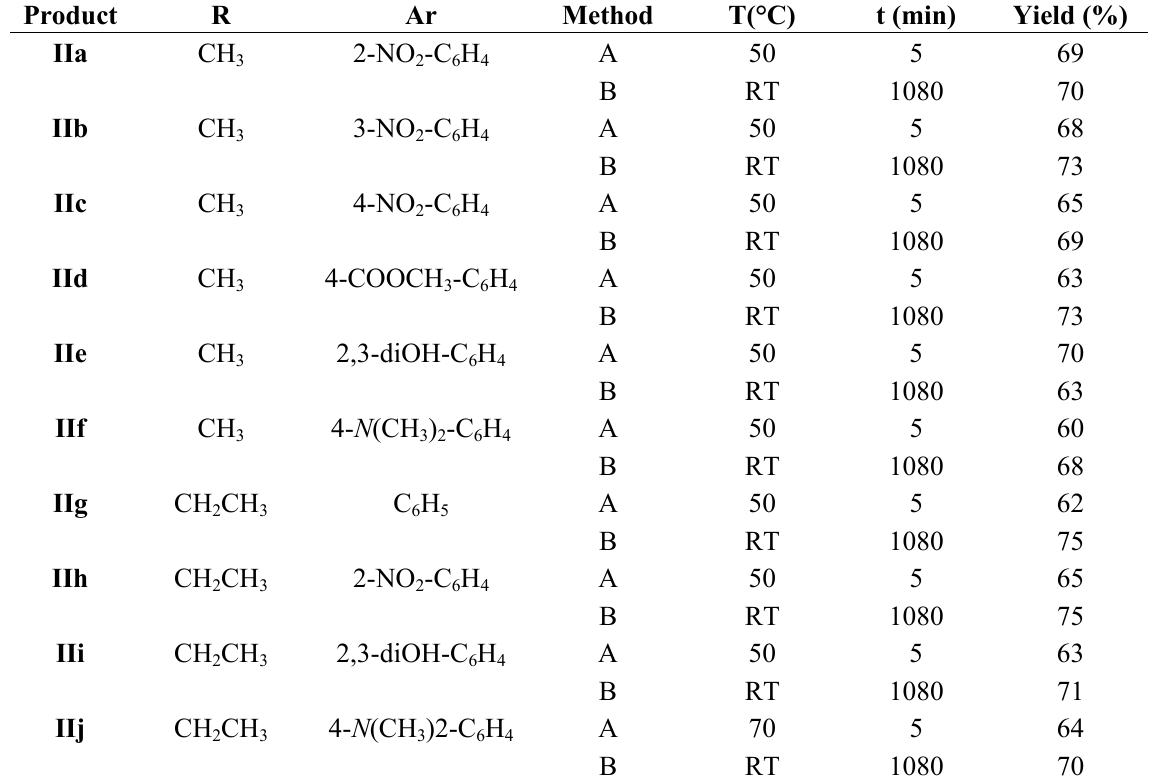
Table 1. Results of MWAS (Method A) of alkyl